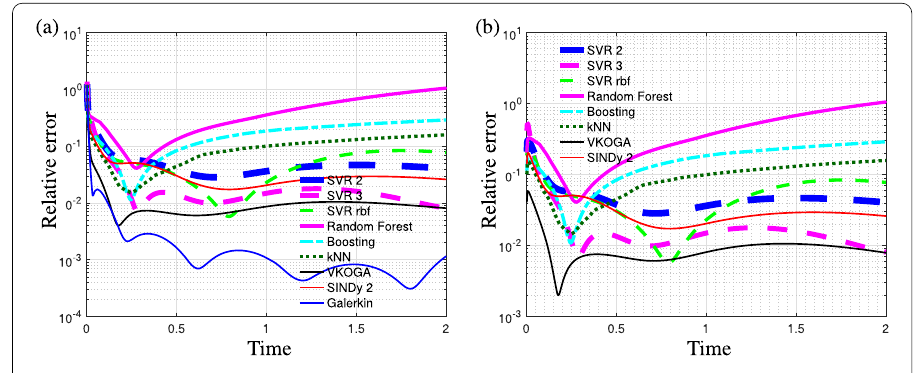
Fig. 8 Backward Euler for 2D convection–diffusion equation: time evolution of relative error: a e FOM ( t ) in FOM; and b e ROM ( t ) in ROM